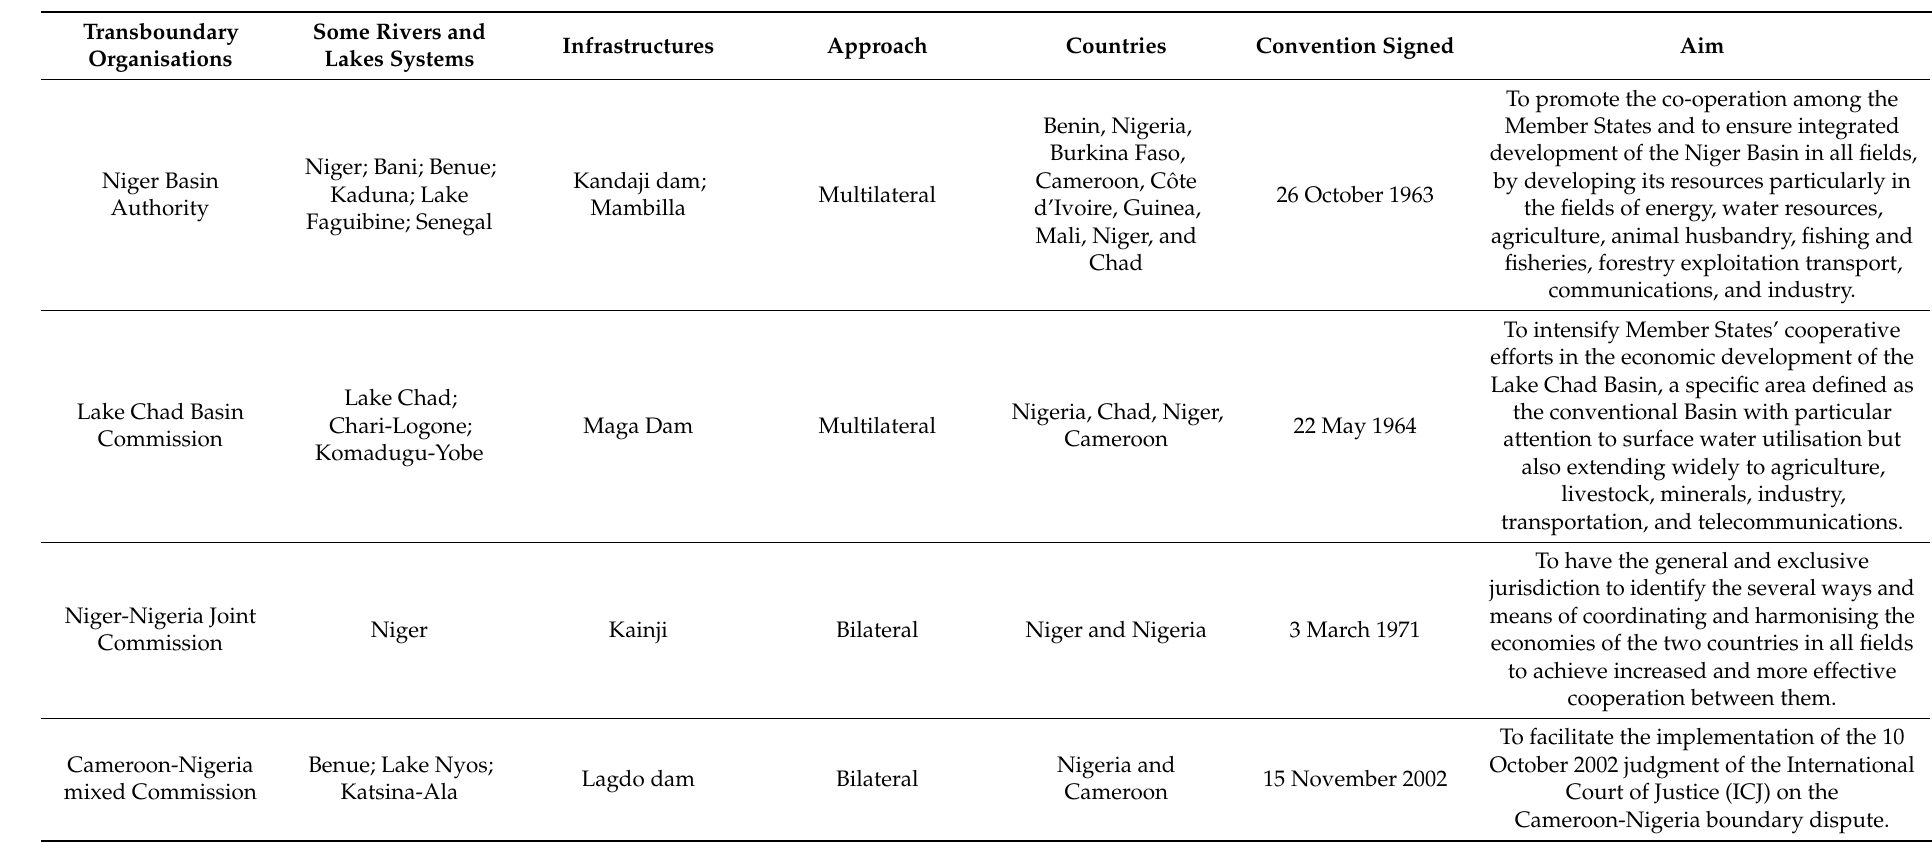
Table A2. Nigeria’s transboundary organisations. Source: